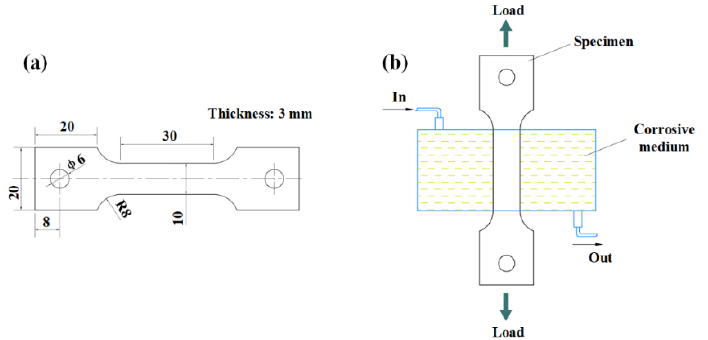
Figure 4. The schematic of ( a ) tensile specimens and ( b ) stress-corrosion testing setup.